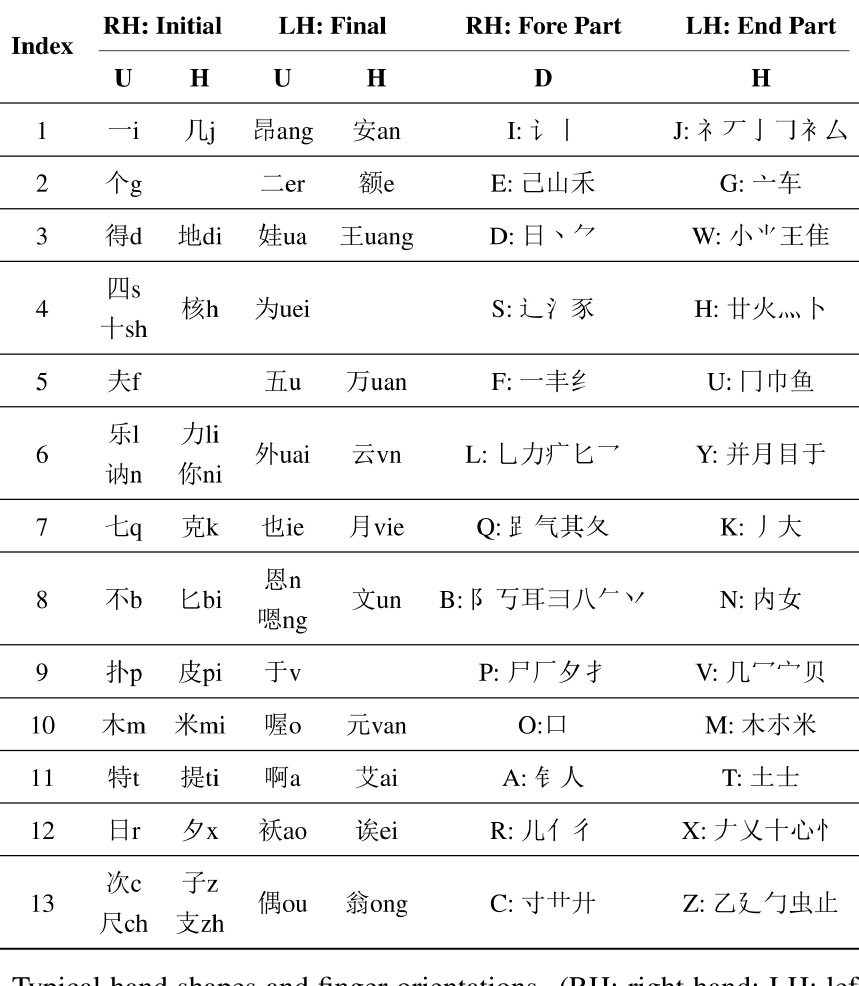
Figure 2. Typical hand shapes and finger orientations. (RH: right hand; LH: left hand; U: upward; H: horizontal; D: download.)